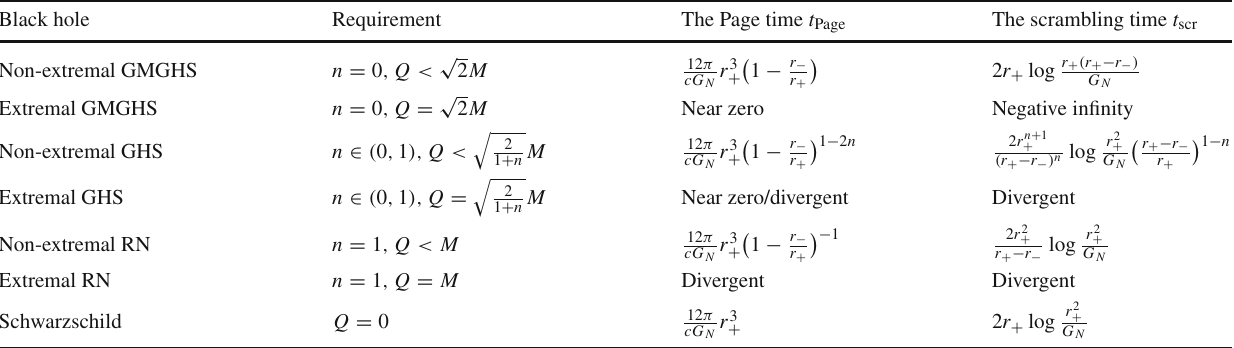
Table 1 The results of the Page time and the scrambling time for different conditions. The results of Schwarzschild black holes and RN black holes are consistent with [19,20] Black hole Requirement The Page time t